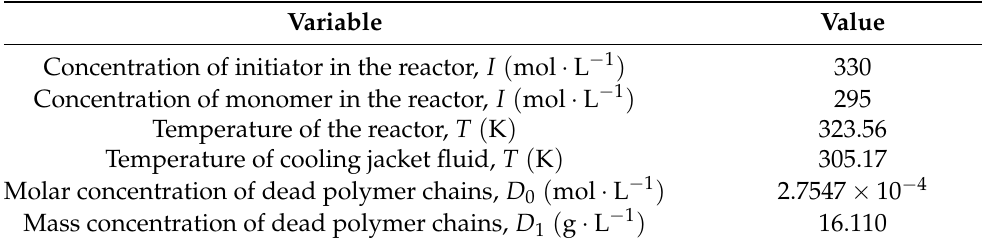
Table 4. Output variables at